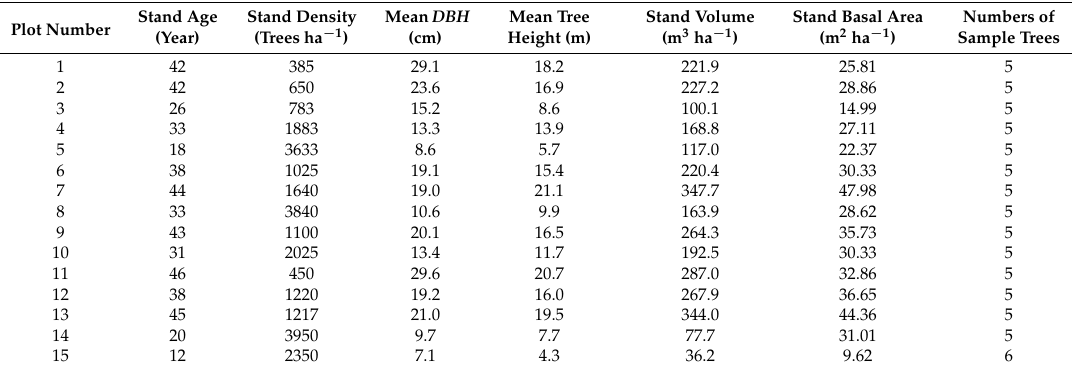
Table 1. Summary of the stand attributes for the 15 sample plots.